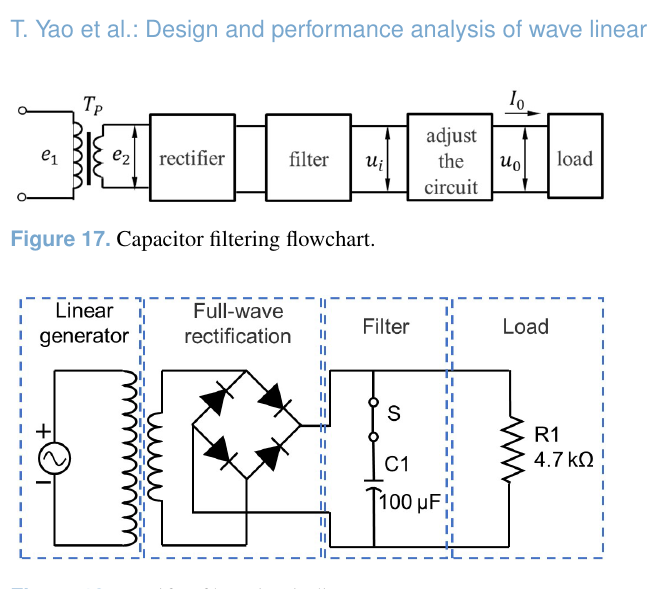
The circuit signals of lossy loads such as pulses and har- monics are filtered out through capacitor filtering, and a rela- tively smooth current is obtained. The general idea is shown in Fig. 17.